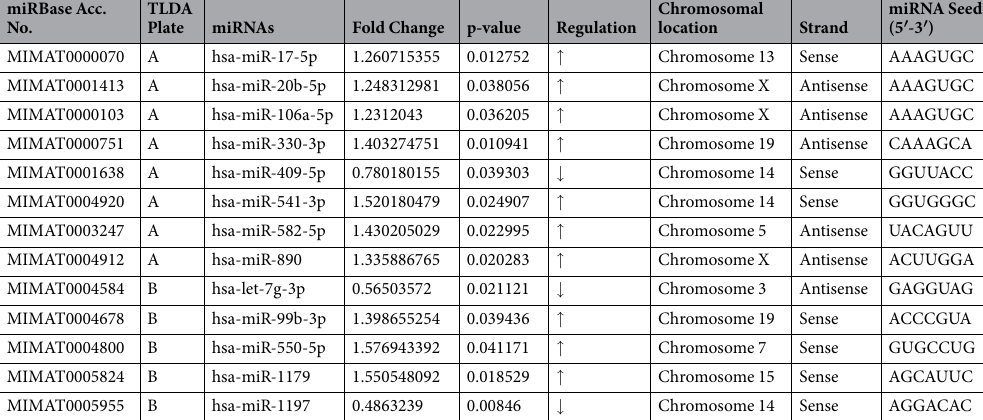
Table 2. significantly altered miRNAs in locus coeruleus of MDD-suicide